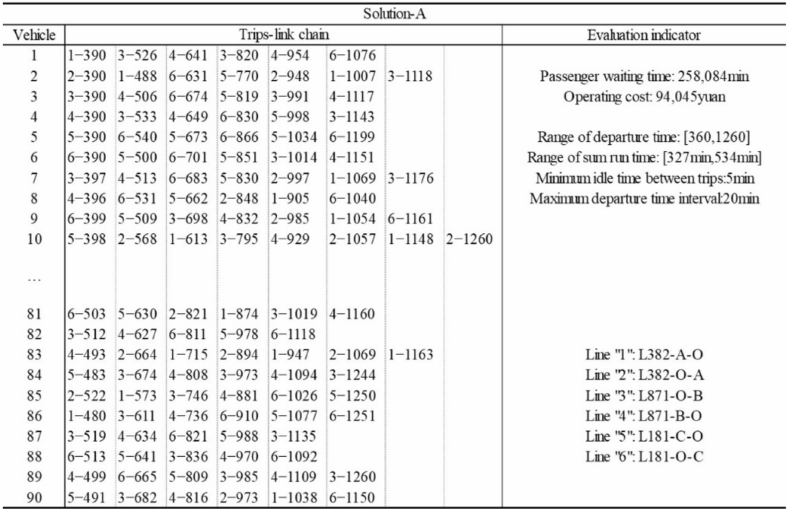
Figure 13. A demonstration of Solution-A.